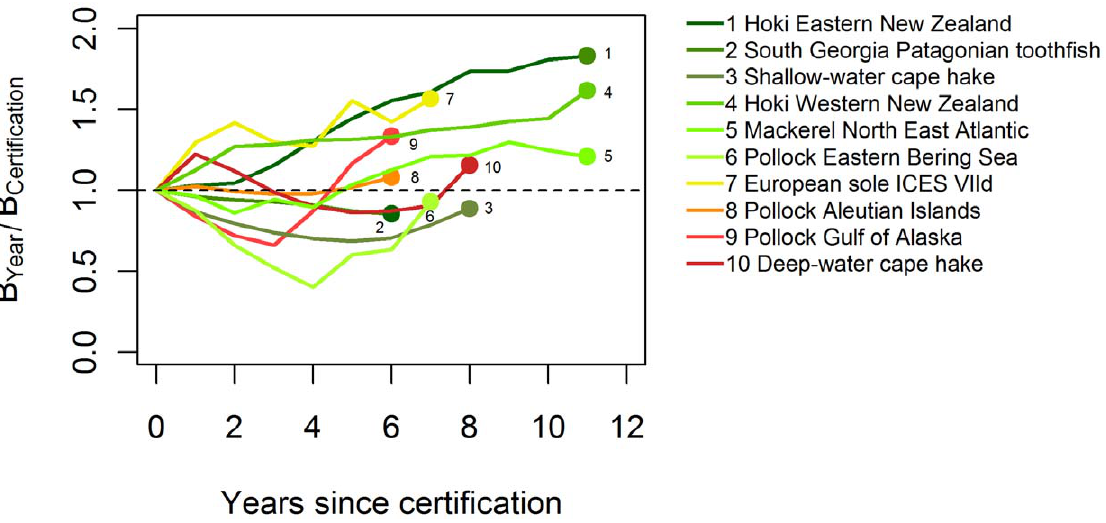
Figure 2. Time trends of current biomass (total or spawning) relative to biomass levels at the time of MSC assessment for stocks with available information and more than 5 years of certification. Colors represent current stock status (green to yellow: B . B MSY; orange to red: B , B MSY) and dots represent most recent year of available information (as per Table S1). doi:10.1371/journal.pone.0043765.g002 PLOS ONE |